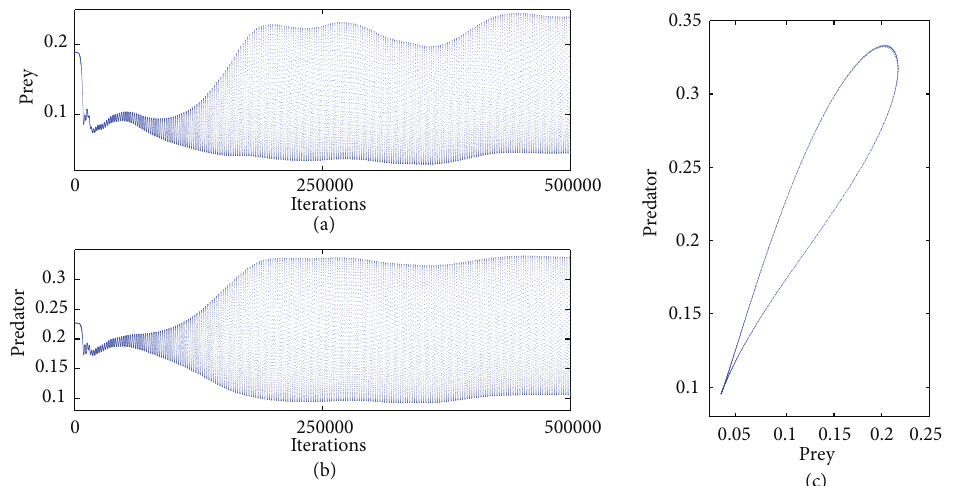
Figure 7: Dynamical behavior of system (3) for a fixed point (0.1892, 0.2270) when 𝑑 2 = 7 and 𝛿 = 0.34 : (a) time series of prey, (b) time series of predator, and (c) the stable limit cycle of system